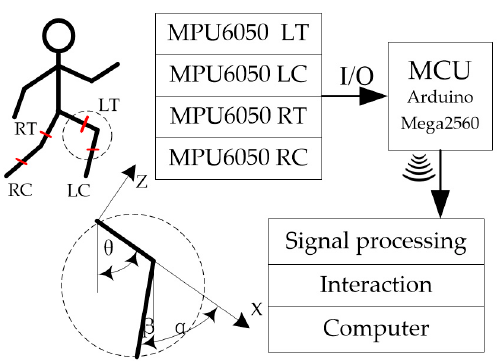
Figure 1. Joint angle schematic diagram of the unit employed (R: right, L: left, T: thigh and C: calf).